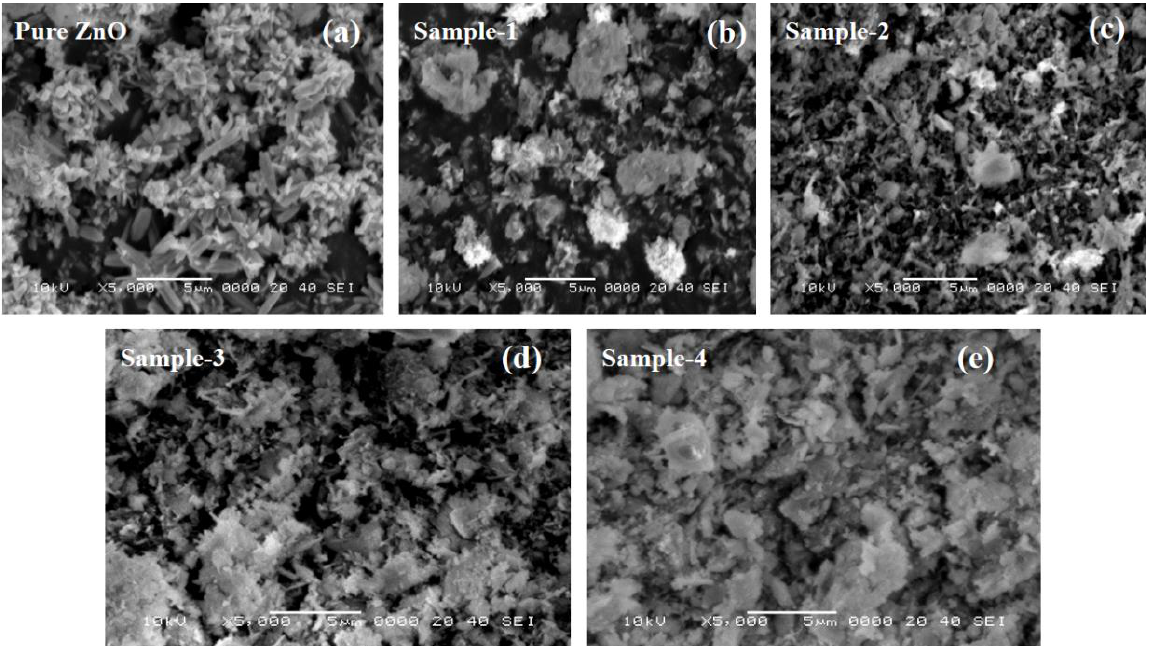
Figure 2. SEM images of ( a ) pristine ZnO and ( b – e ) Mn 3 O 4 @ZnO materials synthesized by sol-gel method.